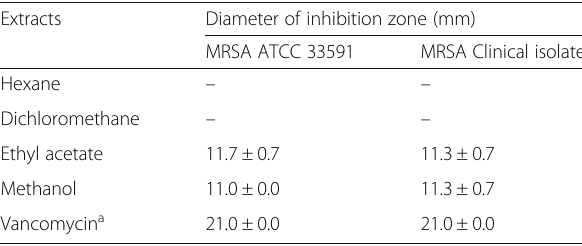
Table 1 Antibacterial activity towards MRSA of B. kockiana flower sequential extracts (1.0 mg/disc) evaluated using disc diffusion assay Extracts Diameter of inhibition zone (mm)